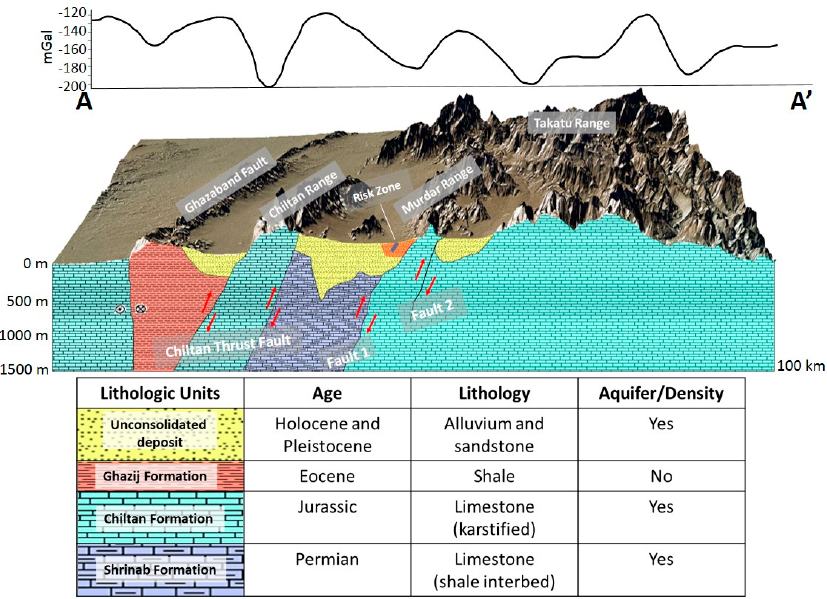
Figure 7. Schematic cross-section AA’ (parallel with seismic profile 3) modified from a previous study [20] to explain subsidence in the Quetta Valley and surrounding areas. The Bouguer anomaly profile of AA’ shows highs and lows forming a trend likely related to mountain ranges and basins. This model shows the activity of blind thrust faults 1 and 2 mapped in subsurface using 2D seismic profiles, which are part of the Chiltan Thrust System. High-risk locations for potential fissures are shown near the Murdar Range based on differential compaction theory in Section 2.5.